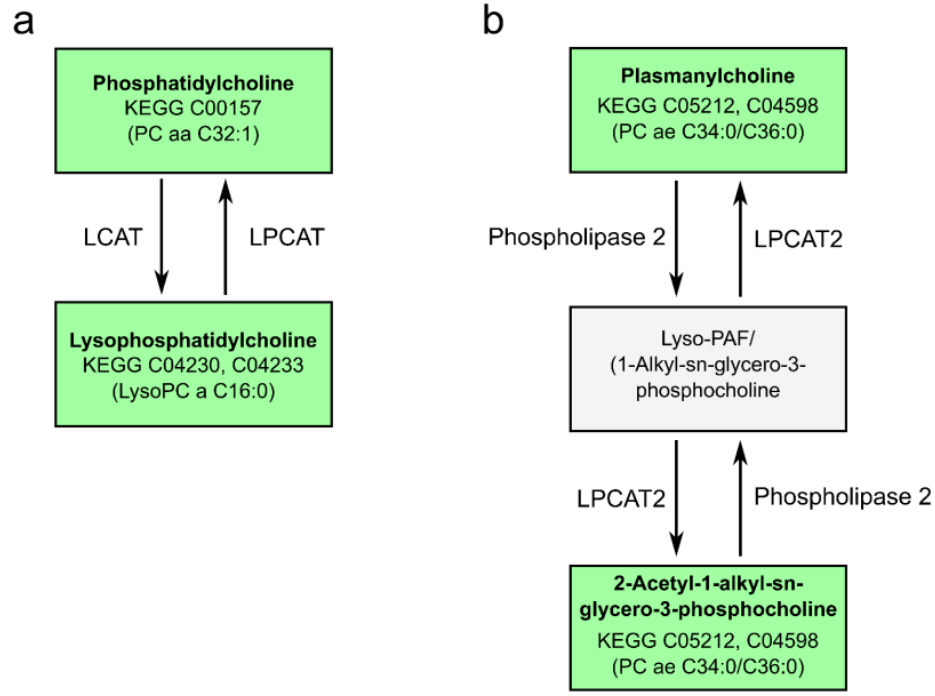
Figure 6. Schematic depiction of pathways detected in plasma MV by pathway analysis. Glyc- erophospholipid metabolism ( a ): relevant metabolites detected by metabolomics were involved in the enzymatic reaction catalyzed by lecithin-cholesterin acyl transferase (LCAT) and lysophos- phatidylcholine acyltransferase (LPCAT).Changes in ( a ) were detected comparing the controls to all breast cancer patients and to the subgroup luminal B. Ether lipid metabolism ( b ): pathway analysis suggested involvement in the reaction catalyzed by LPCAT or phospholipase 2 when comparing metabolites of the control group to subgroup luminal B.